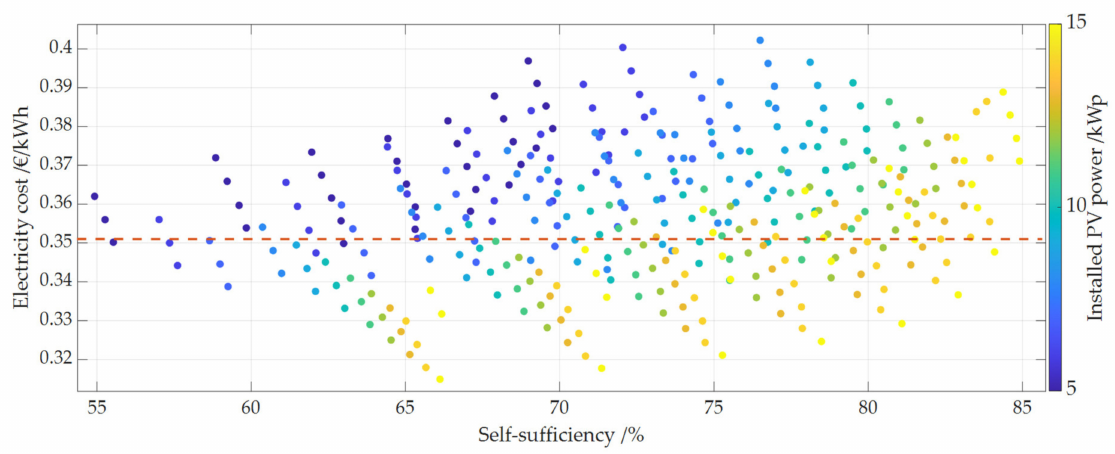
Figure 9. Electricity costs as a function of self-sufficiency, the size of the PV system is shown in color. The simulation is based on an annual electricity price increase of 1%.